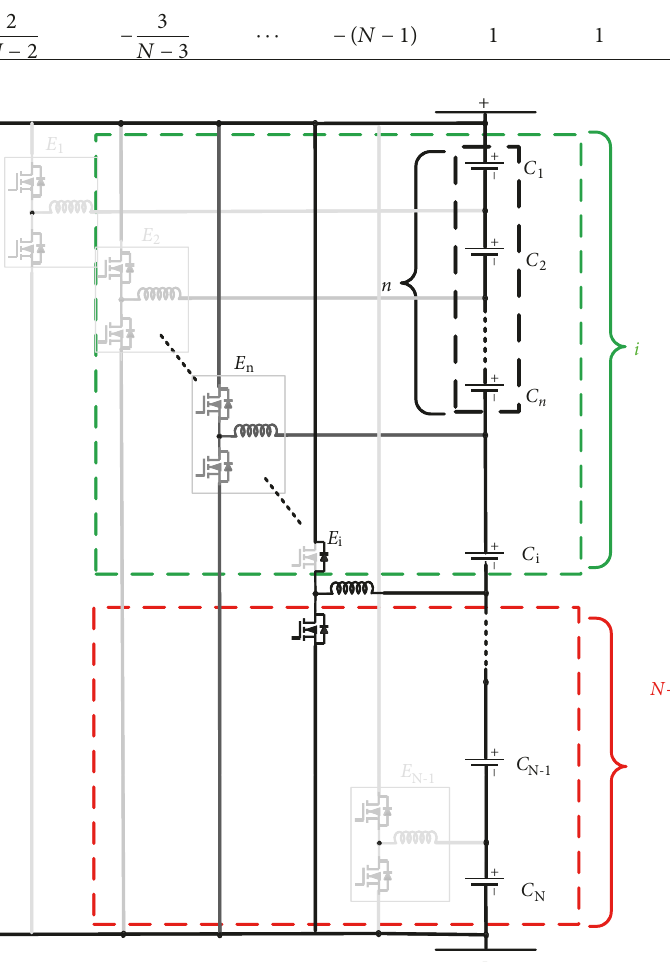
Figure 7: Energy transfer caused by the equalizer E i in situation